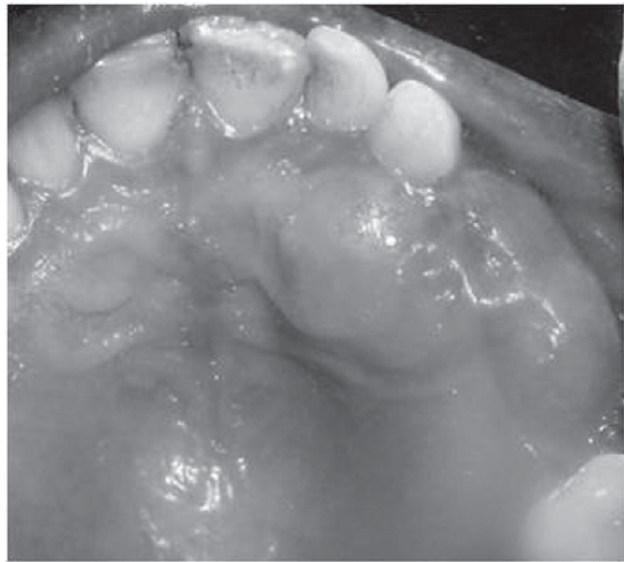
Fig. 1. Photograph showing bicortical expansion on maxilla with intact